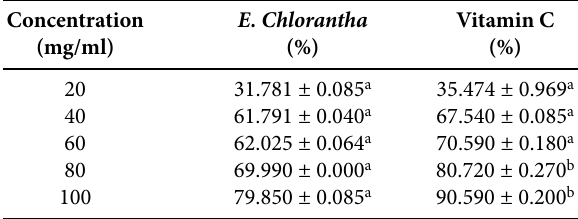
Table 2. % DPPH (2,2-diphenyl-1-picrylhydrazyl) inhibition of E. chlorantha extract Concentration